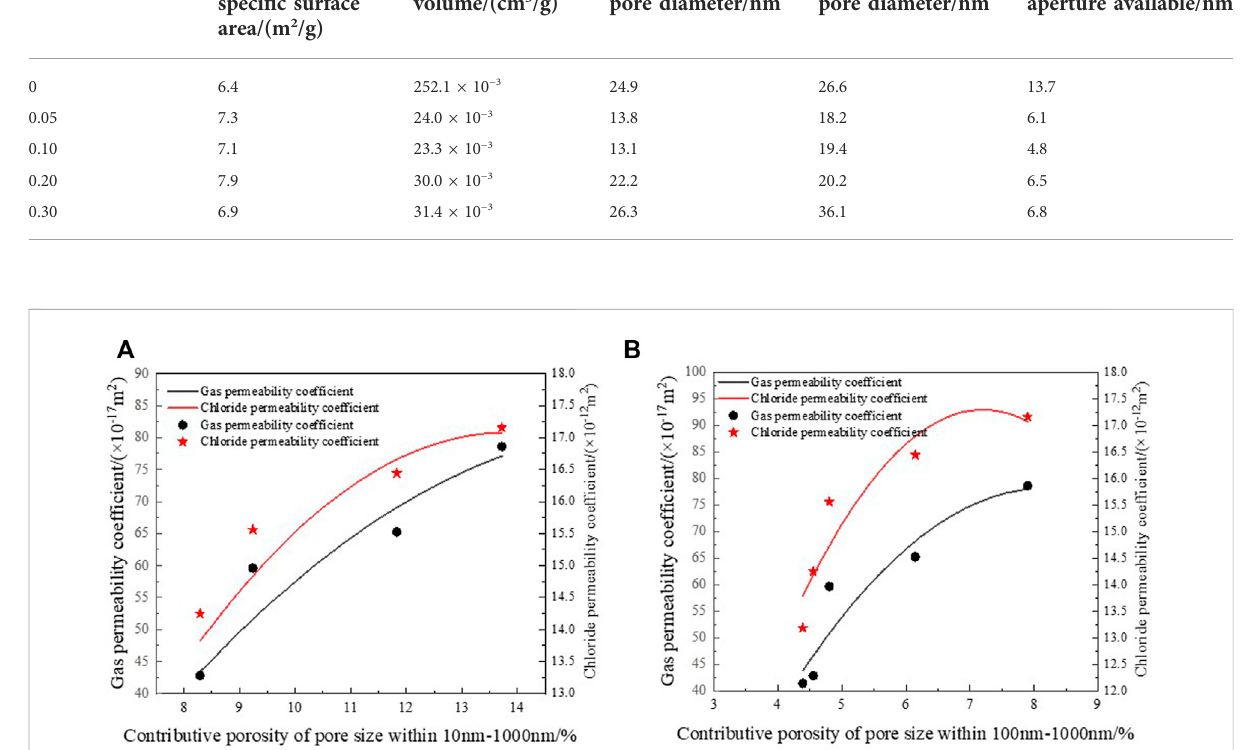
FIGURE 12 Relationshipbetweenpermeabilityandthecontributiveporosityofporesizeinconcrete(Zhangetal.,2018) (A) Poresizewithin10 – 1000 nm (B) Pore size within 100 – 1000